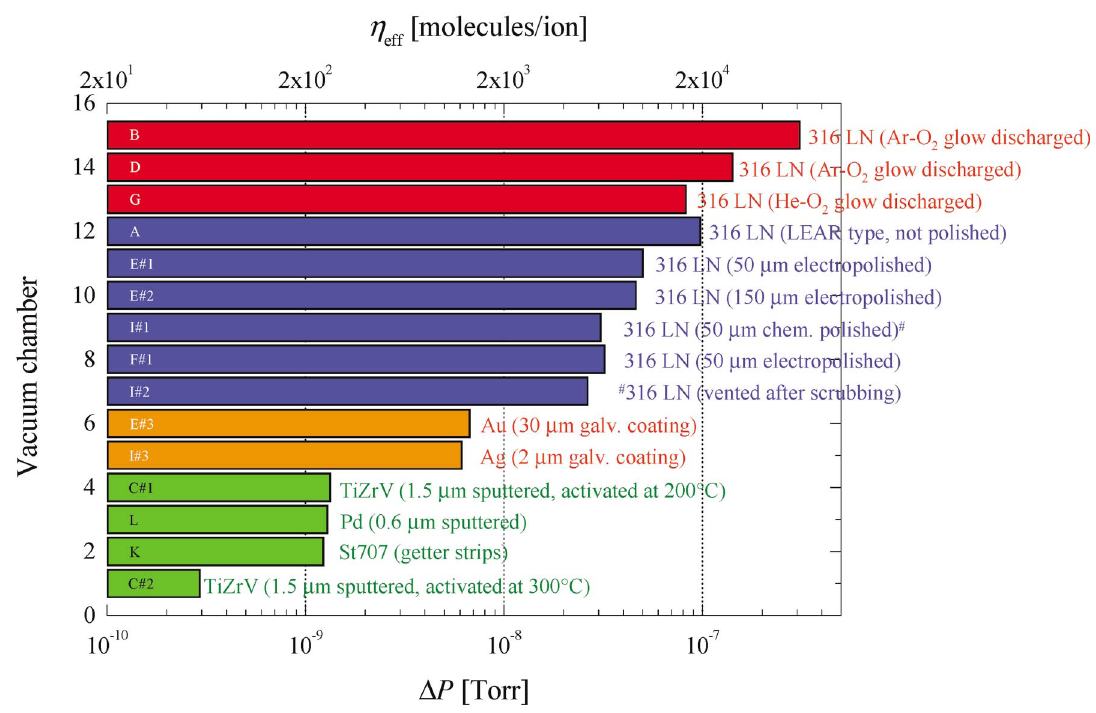
FIG. 6. (Color) Summary of pressure rise measurements for 15 different surfaces (10 different vacuum chambers) continuously bombarded with (cid:4) 1 : 5 (cid:1) 10 9 Pb 53 (cid:2) ions under (cid:8) (cid:6) 89 : 2 (cid:7) grazing incidence. The pressure increase (cid:26) P is measured at the beginning of each scrubbing run. The plot summarizes the LINAC 3 results obtained between November 2000 and October